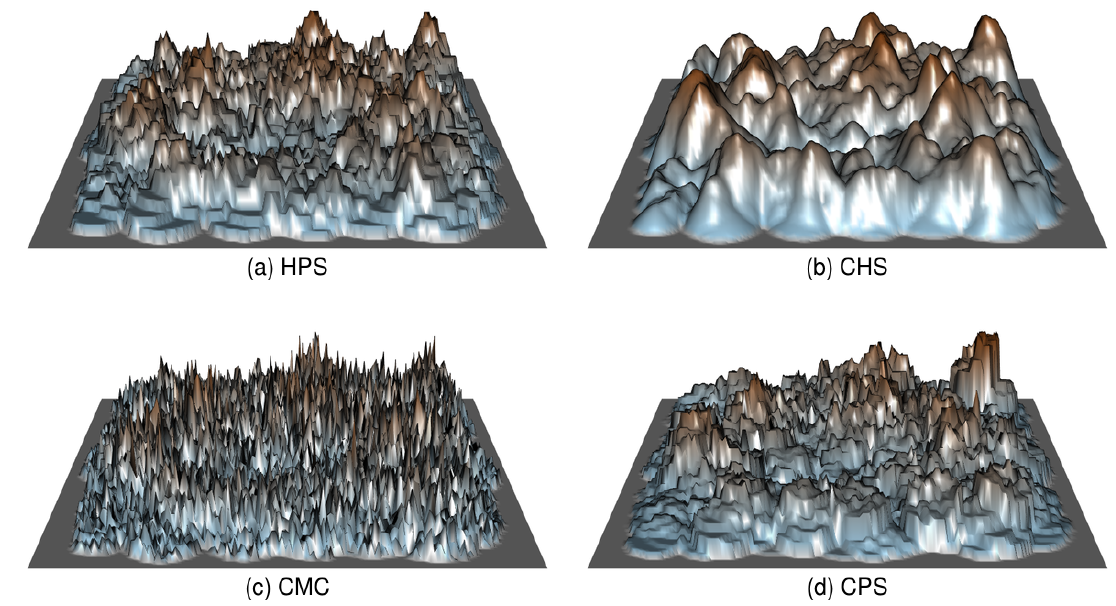
Figure 1. Perspective view of the sampling surfaces from the simulations in Table 1 illustrating the four sampling methods: ( a ) HPS; ( b ) CHS; ( c ) CMC, all with F = 3 m 2 ha − 1 ; and ( d ) CPS with R = 8.92